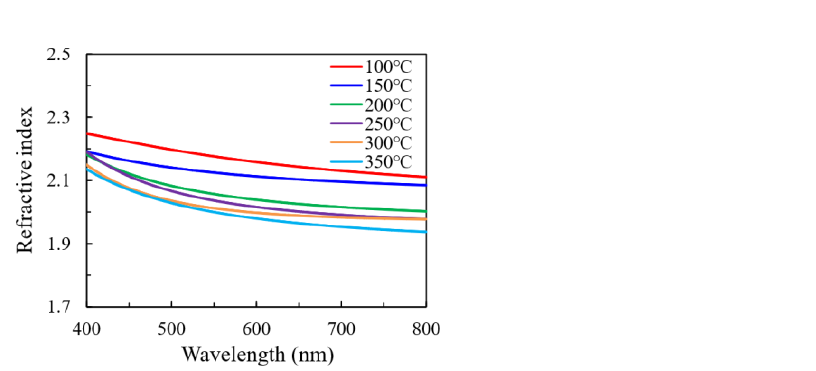
Figure 9 . The wavelength-dependent refractive index of In 2 O 3 films deposited at different sub- strate temperatures. strate